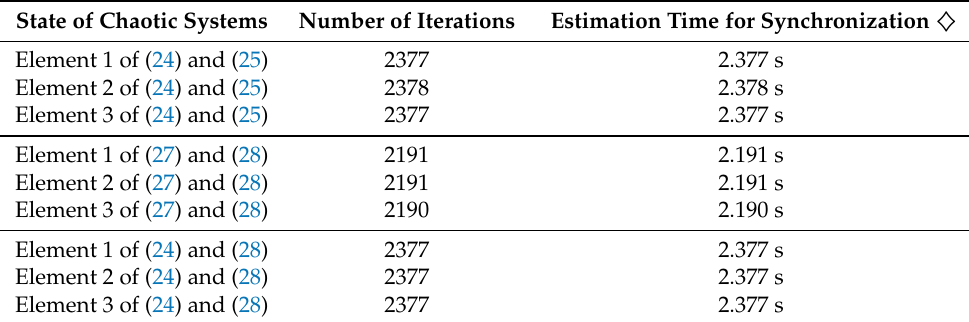
Table 4. Number of iterations and estimation time for synchronization of chaotic systems in three synchronization